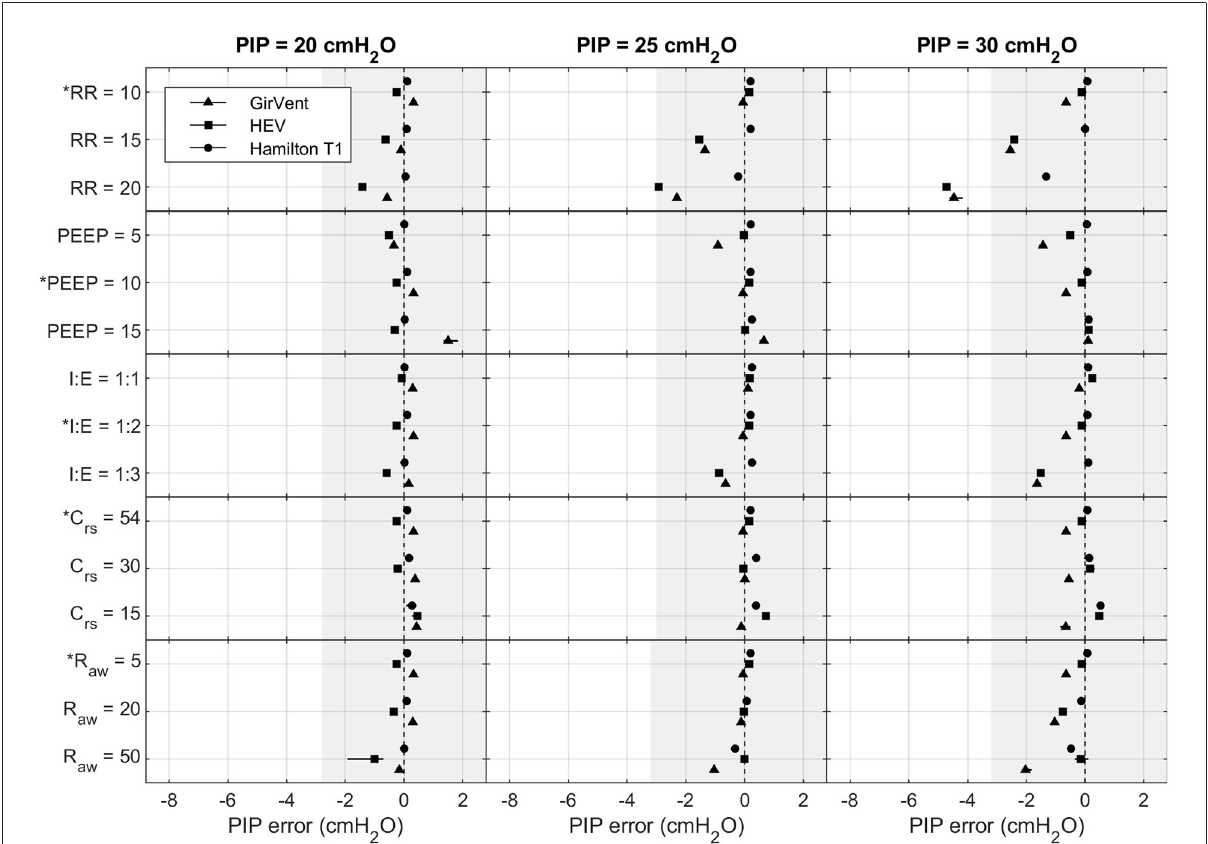
FIGURE4 Measured PIP error in the Hamilton T1 (PCV + mode), the HEV, and the GirVent: effects of altering PIP (cmH 2 O), RR (bpm), PEEP (cmH 2 O), I:E (ratio), Crs (mL cmH 2 O − 1 ), and Raw (cmH 2 O s L − 1 ). The base setting is indicated by * . The markers and lines denote the mean error and the maximum and minimum errors, respectively. The grayed-out area indicates the acceptable performance tolerance according to the ISO 80601-2-12 norm and the MHRA specification.